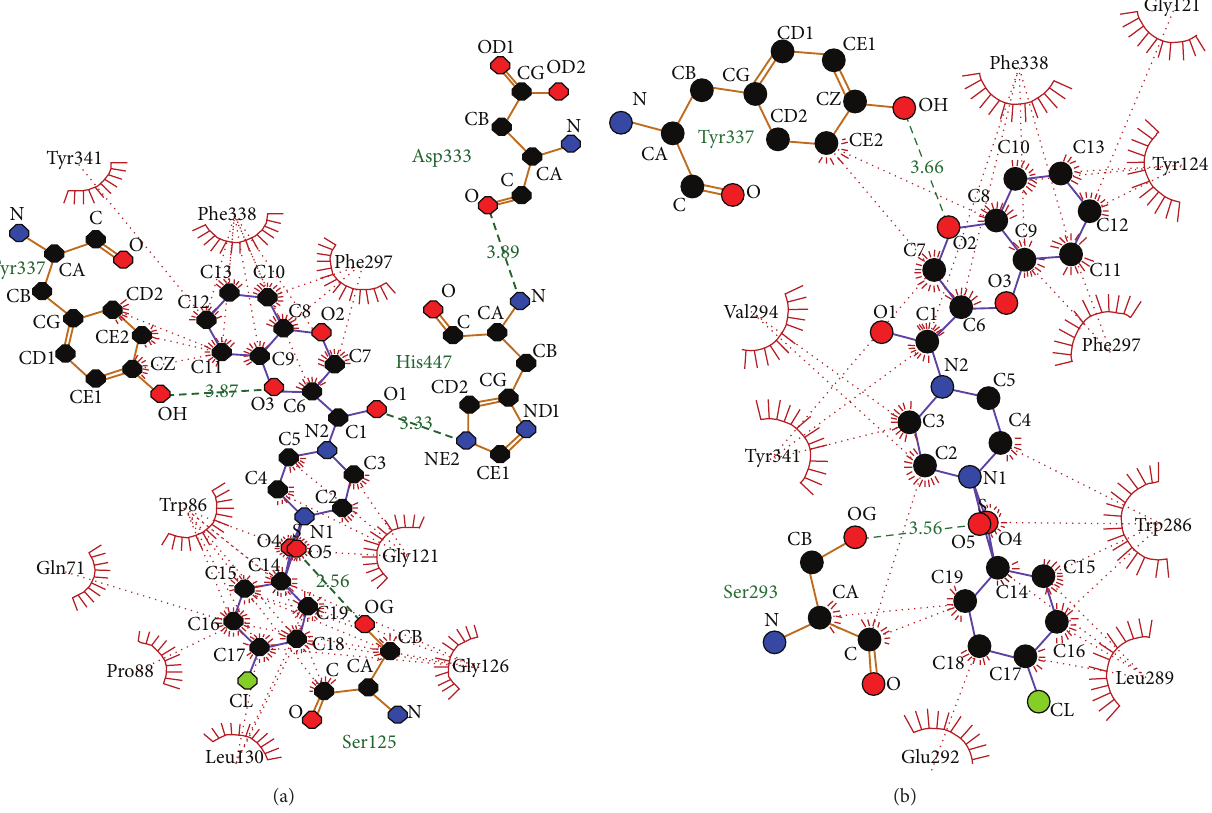
Figure 5: (a) Catalytic site docking of 4-(4-chloro)-benzenesulfonyl-1-(1,4-benzodioxane-2-carbonyl) piperazine (S3). (b) Peripheral anionic site docking of 4-(4-chloro)-benzenesulfonyl-1-(1,4-benzodioxane-2-carbonyl) piperazine